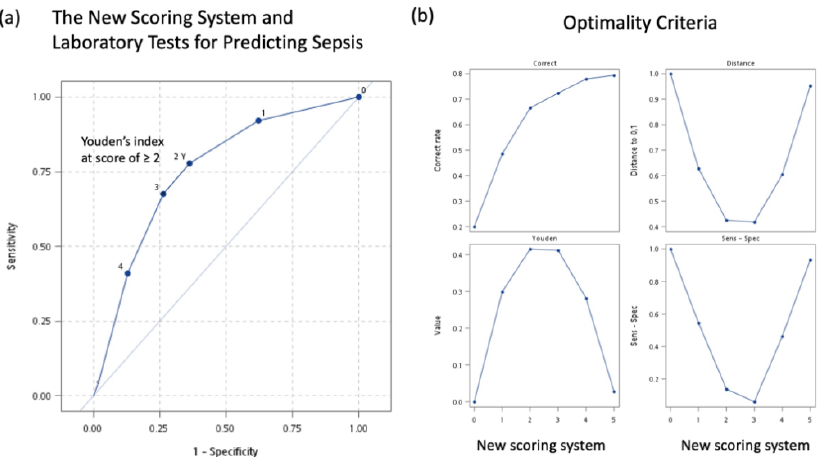
Figure 4. ( a ) Receiver of operating characteristic (ROC) curve of the New Scoring System and Laboratory Tests for Predicting Sepsis. ( b ) The optimality criteria of the New Scoring System and Laboratory Tests for Predicting